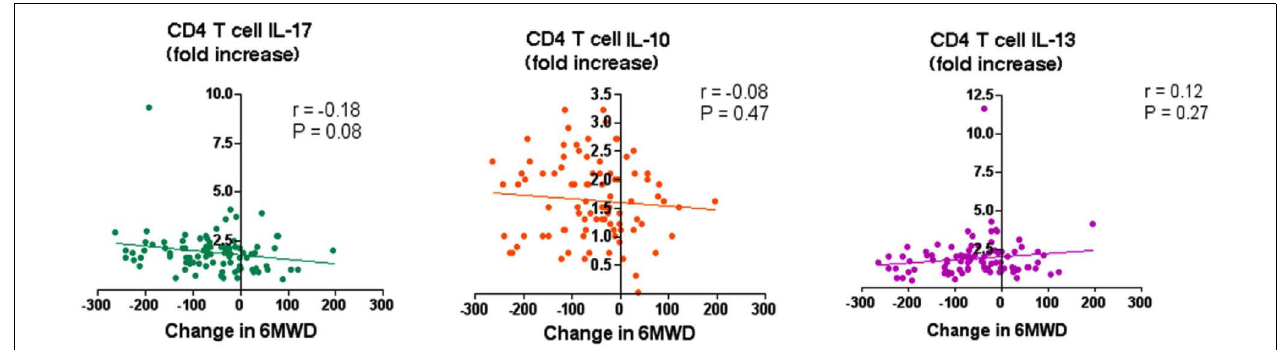
change of CD4 + T cells in ever-smokes ( n = 90) in IL-17, IL-10, and IL-13 in response to elastin fragments over nil stimulation. No significant associations were found among these three cytokines and changes detected in 6MWD.